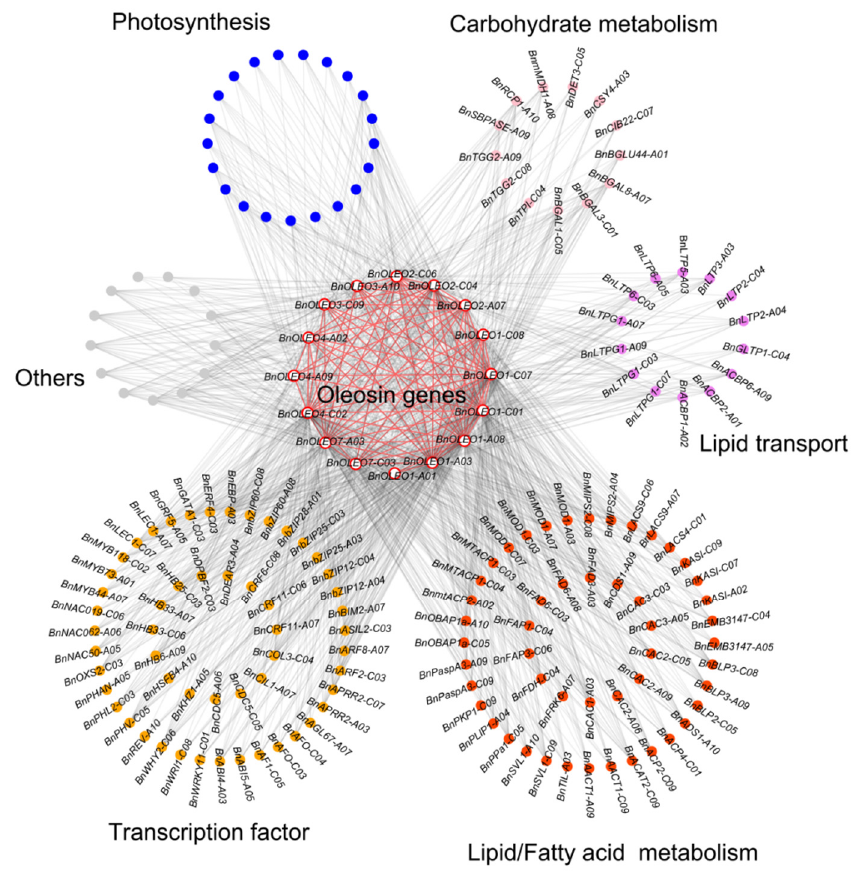
Figure 5. Co-expression network analysis of BnOLEO genes.